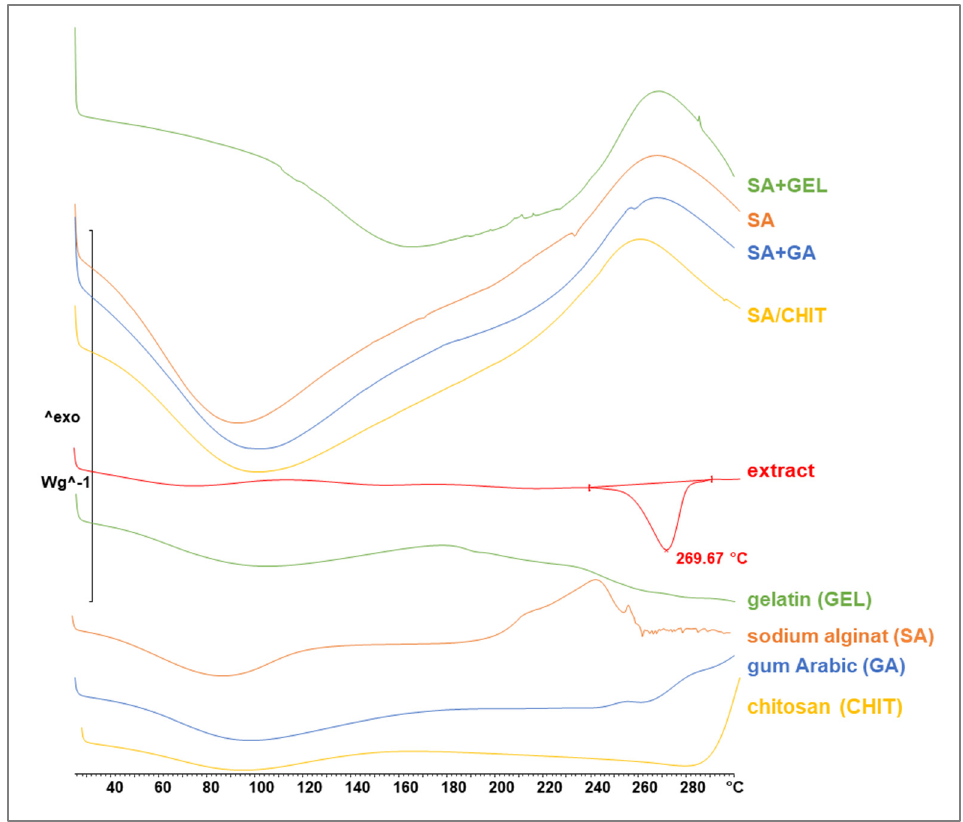
Figure 5. Differential scanning calorimetry thermograms of grape pomace extracts, pure coatings (sodium alginate, SA; chitosan, CHIT; gum arabic, GA; and gelatin, GEL), and freeze-dried microbeads containing phenol-rich grape pomace extract prepared using various coatings (SA; combination SA/CHIT; SA + GA; and SA + GEL).